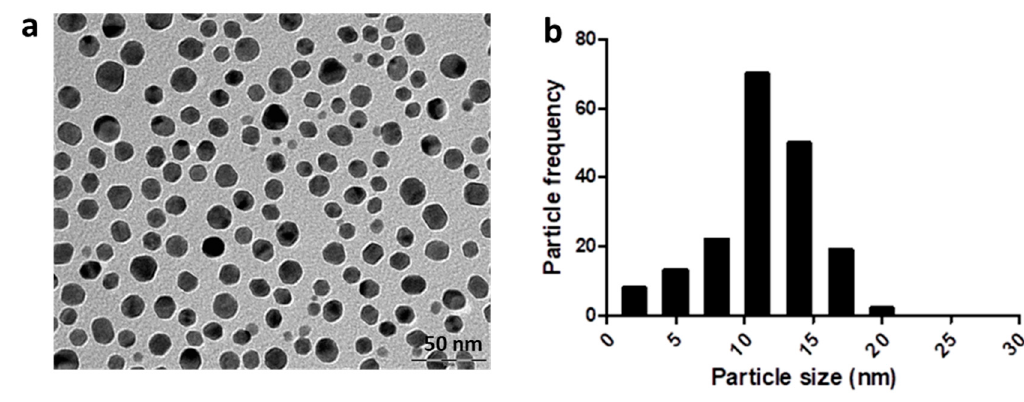
Figure 4. Transmission electron microscopic image of Coptidis rhizome -mediated biosynthesized silver nanoparticles. ( a ) Representative image. ( b ) Particle size histogram.